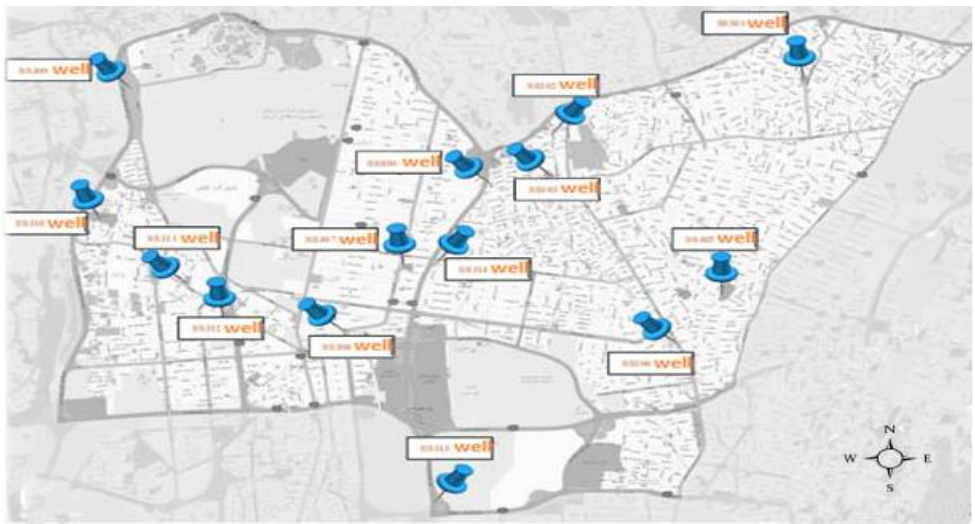
Fig. 2: Location of under study Wells in District 3